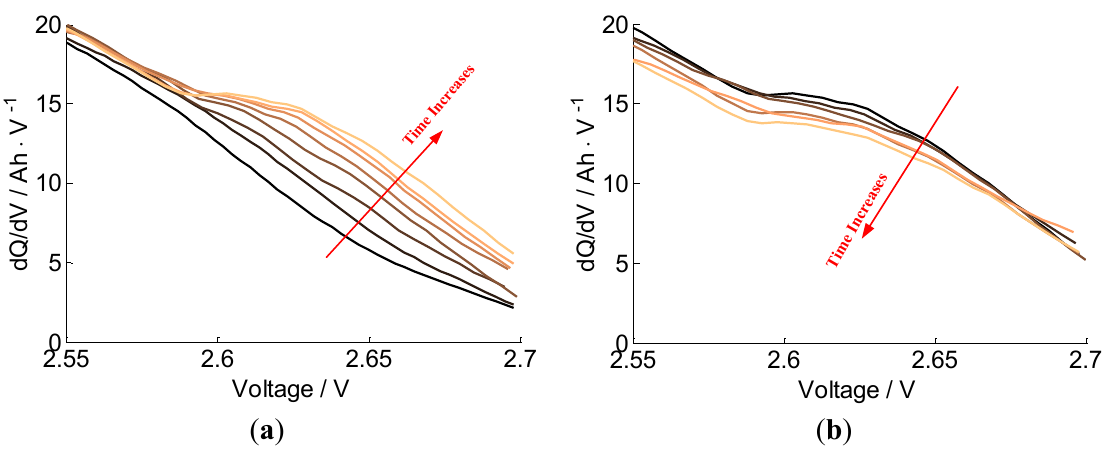
Figure 6. The Region C of IC curves of Cell A after every 90 cycles: ( a ) after 0 cycles up to 630 cycles; and ( b ) after 630 cycles up to 1080 cycles.